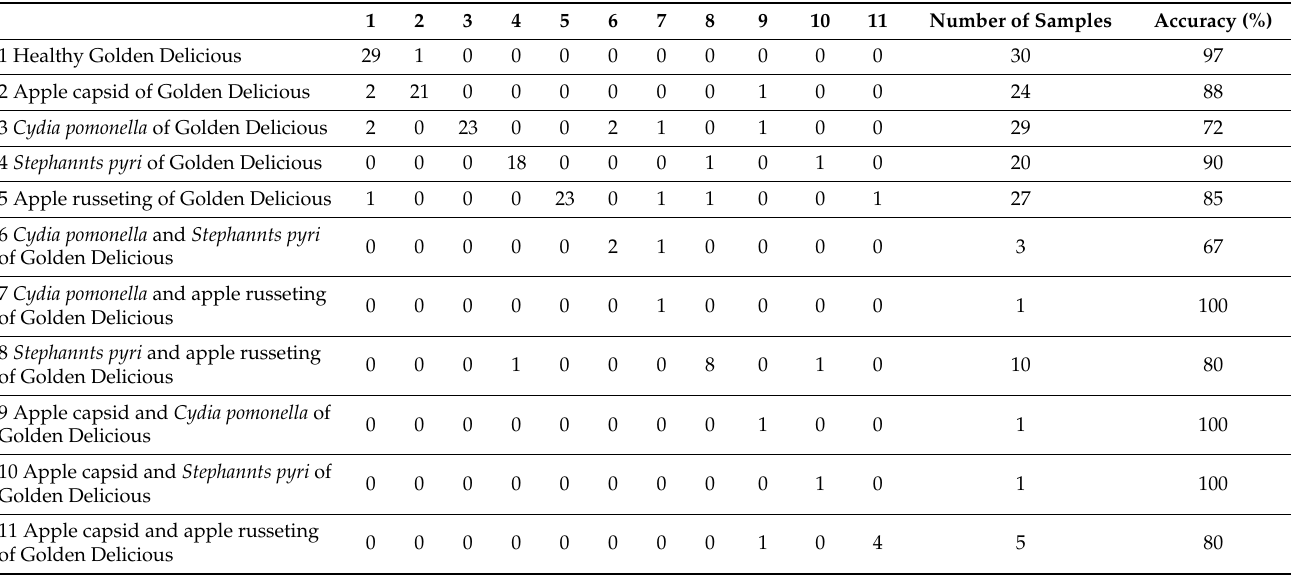
Table 5. Confusion matrix and data classification using sparse coding with three views of Golden Delicious